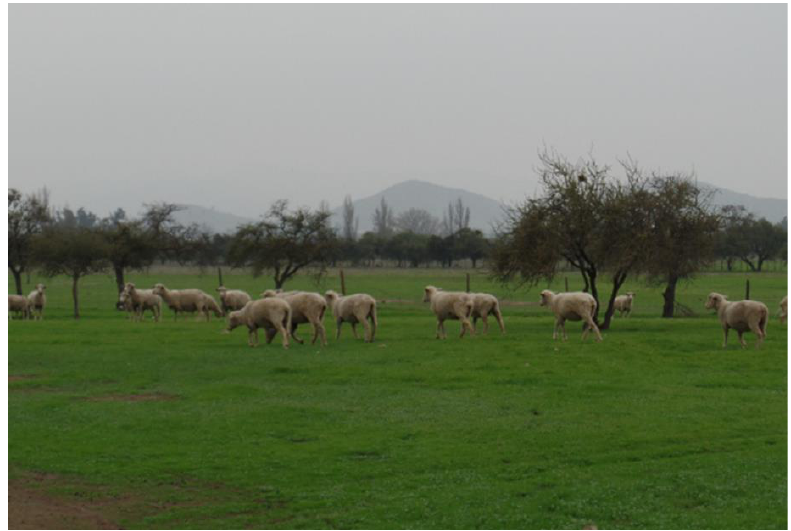
Figure 2. Merino precoz ewes grazing on Mediterranean annual grassland where the experimental study was carried out (fall-winter season).